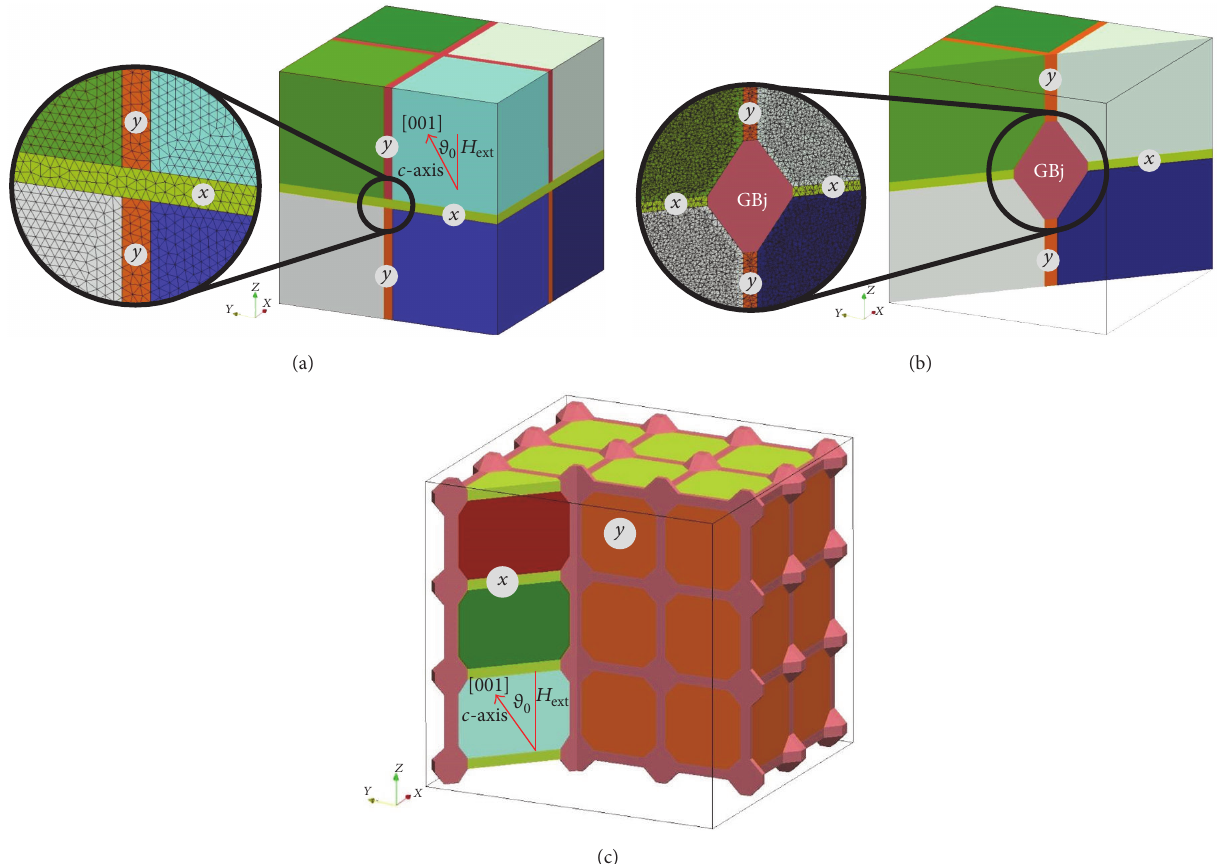
Figure 3: (a) 8-G finite element model structure consisting of 8 Nd-Fe-B grains (50 nm edge, 2nm mesh size) misaligned by 𝜗 0 and separated by 6nm thick 𝑥 - and 𝑦 -GBs (2nm mesh size); (b) cut of the 8-G-GBj model structure with a truncated octahedron GBj with a height of 44nm in the center of the model structure; (c) cut of the 27-G-GBj model structure consisting of 27 grains (30 nm edge, 2nm mesh size) separated by 4nm thick 𝑥 - and 𝑦 -GB and GBj and grain boundary